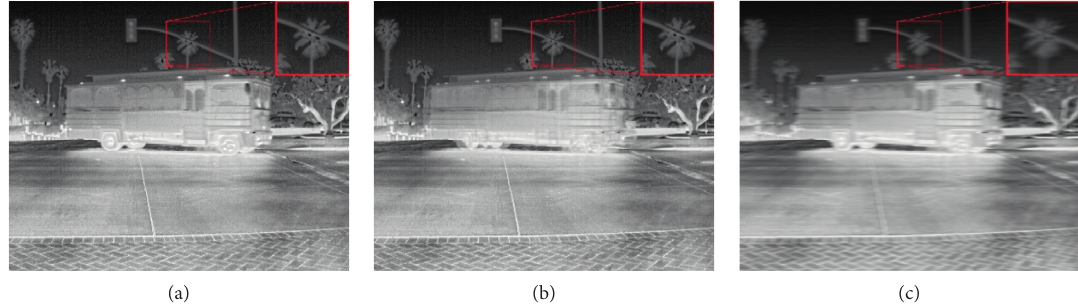
Figure 5: Comparison of synthetic blurred images by different methods. (a) Real clear image. (b) Blurred image synthesized by the average frame method. (c) Blurred image synthesized by the blur kernel